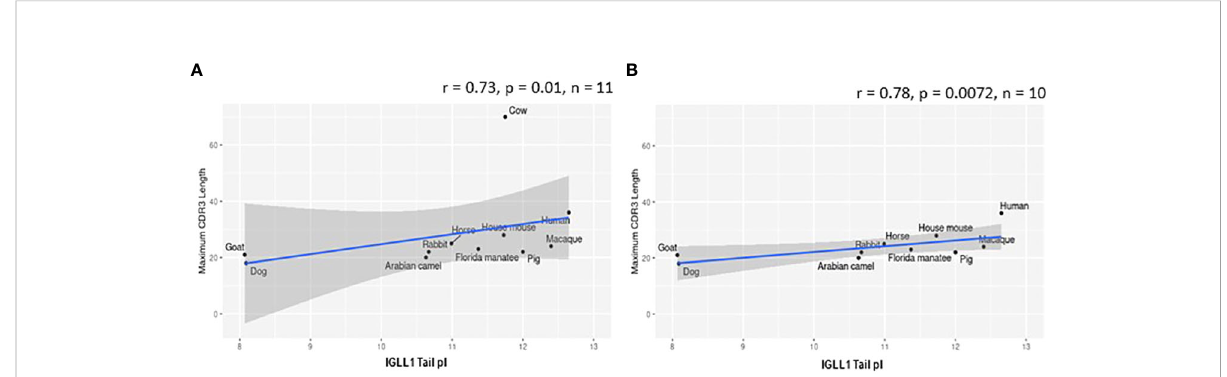
FIGURE 8 Isoelectric point (pI) of IGLL1 tails increases with increasing CDR H3 length. (A) pI of IGLL1 tails was highly correlated with maximum CDR H3 length (r= 0.73; p=0.01; n = 11). (B) This relationship remains even when cattle (with ultralong DH segments) are removed from the dataset (r=-0.78; p=0.0072; n =